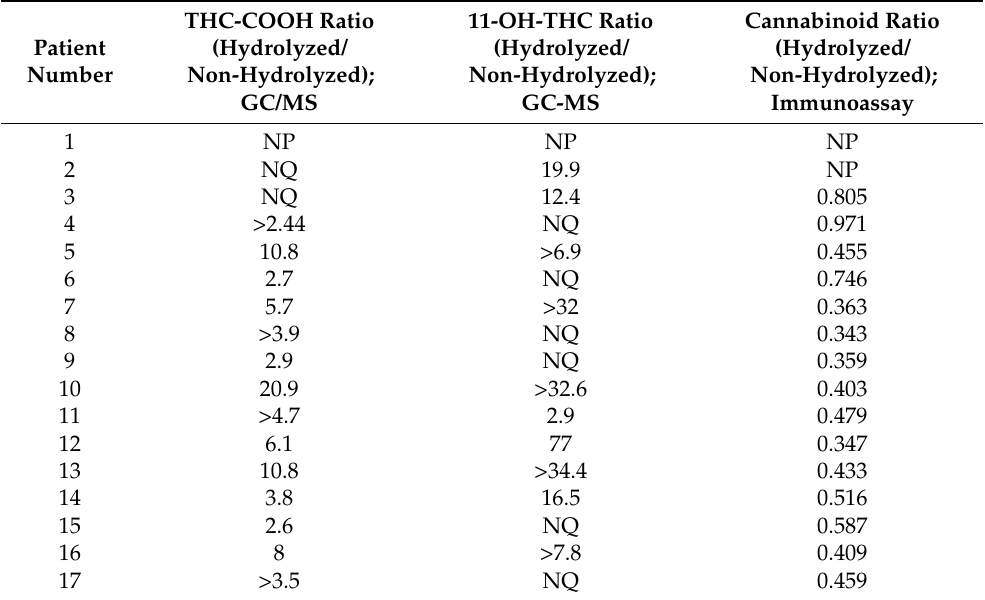
Table 3. Ratios of cannabinoid concentrations after hydrolytic and non-hydrolytic processing of urine samples. Columns 2 and 3 show the ratios of concentrations measured by GC/MS, while Column 4 shows the ratio of cannabinoid concentrations measured by the immunological